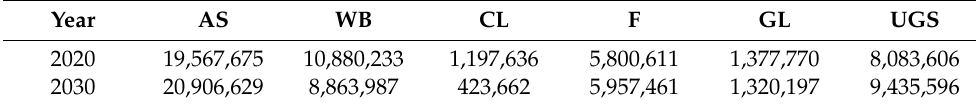
Table 8. The cell number prediction of land use in 2020 and 2030 (Unit: